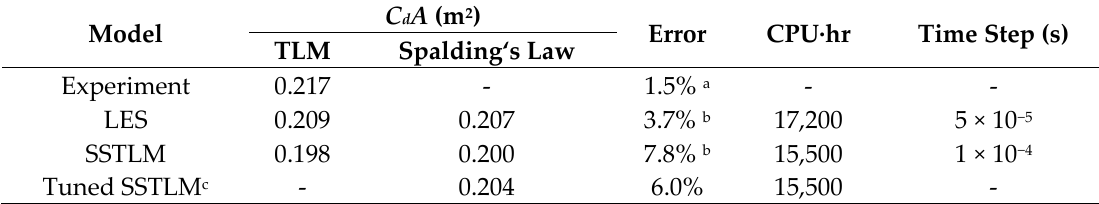
Table 1. Estimated drag area and computational